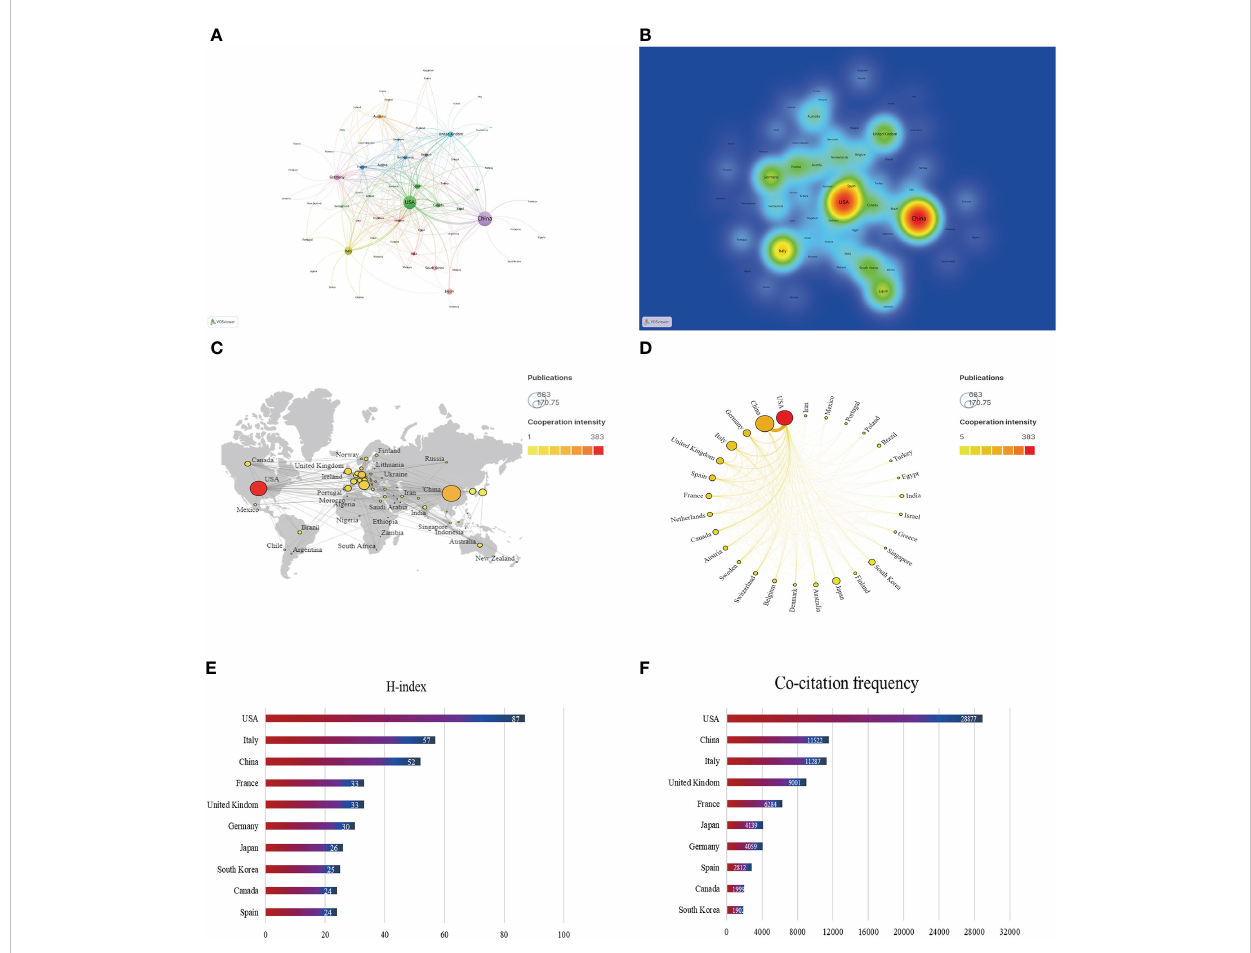
FIGURE 3 Contribution of different countries to the study of the gut-liver axis in NAFLD. (A) The network of collaboration map of countries/regions based on VOSviewer. (B) The density visualization of all participating countries. (C) Geographical distribution map of global publications related to the gut-liver axis in NAFLD. (D) The top 30 countries with the most publications. (E) Top 10 countries for H index. (F) Top 10 in terms of co-citation